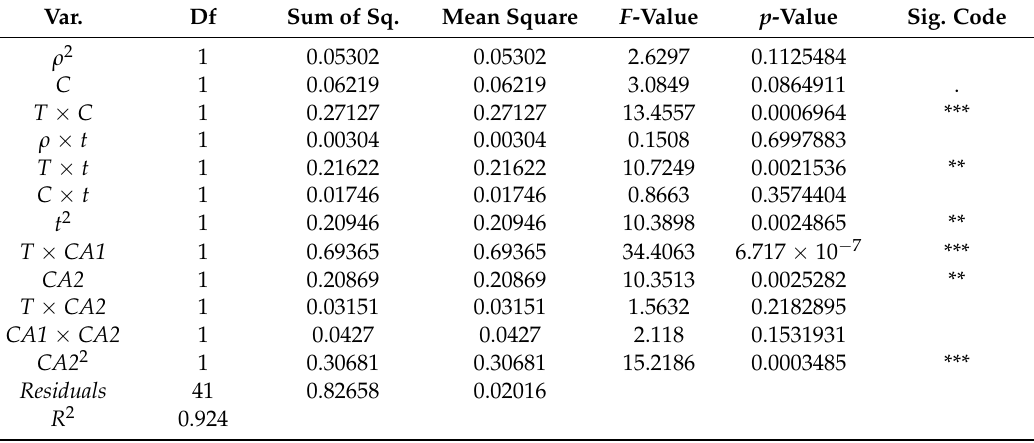
Table 4. ANOVA table for the “ ∆ M ” quadratic model.